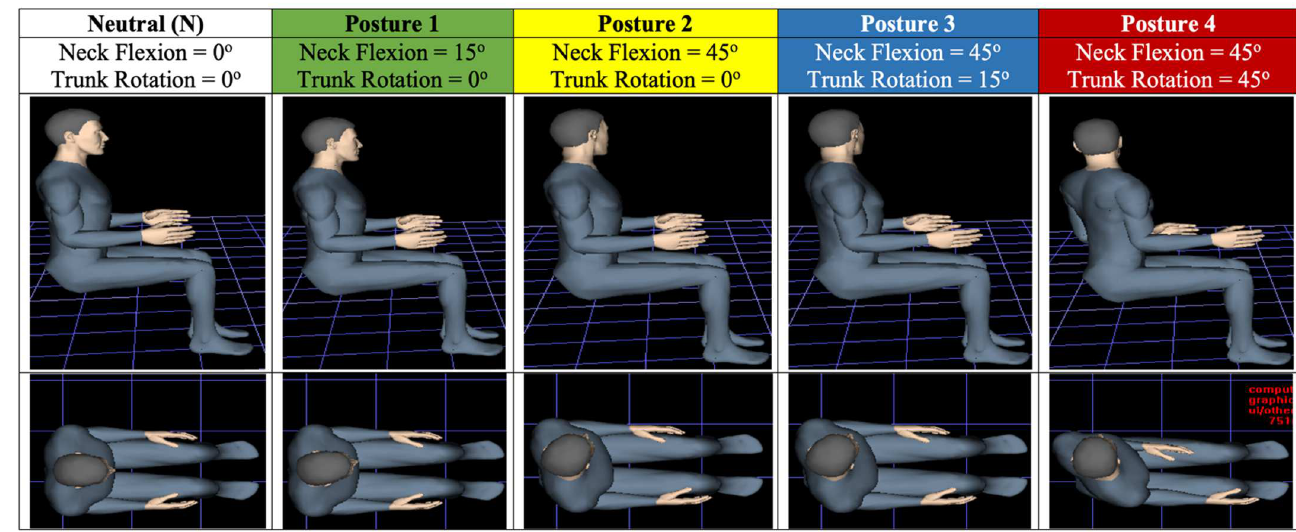
Figure 2. The five postures with their corresponding target position (in degrees) and target